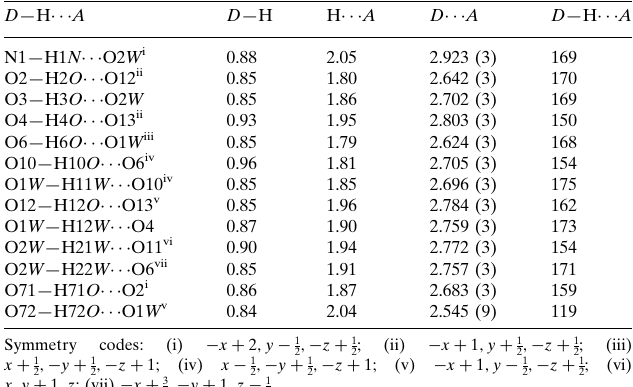
Hydrogen-bond geometry (A˚ , (cid:4)